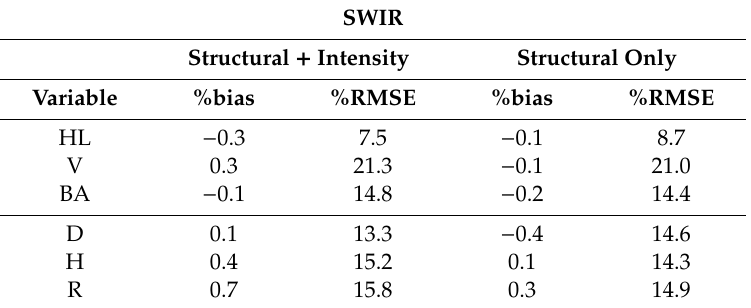
Table 6. %RMSE and %bias results for structural only and combination of structure and intensity models derived from the shortwave-infrared (1550 nm) M-ALS wavelength.